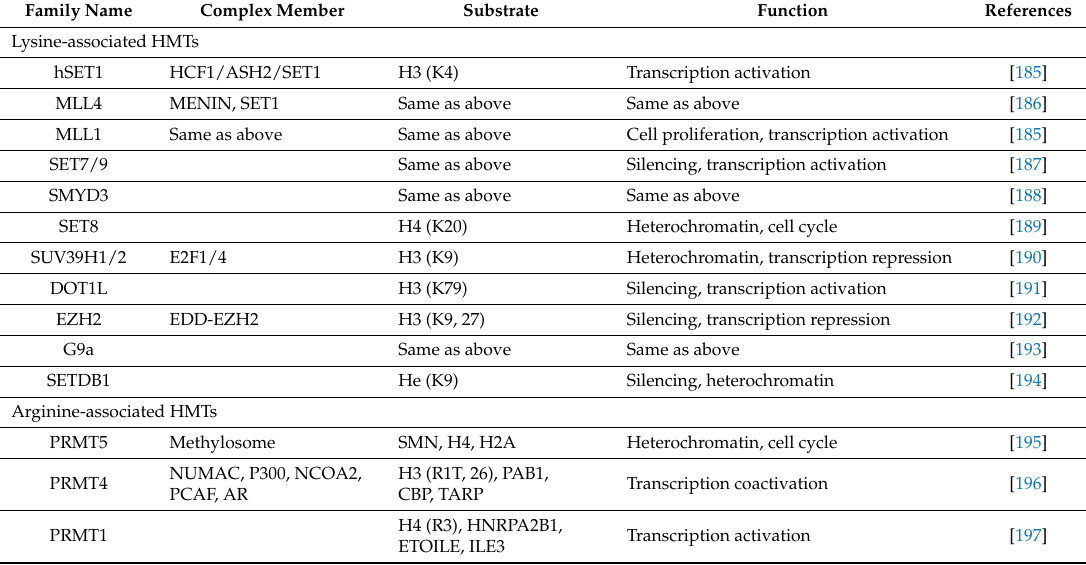
Table 5. Histone methyltransferases (HMTs) and their